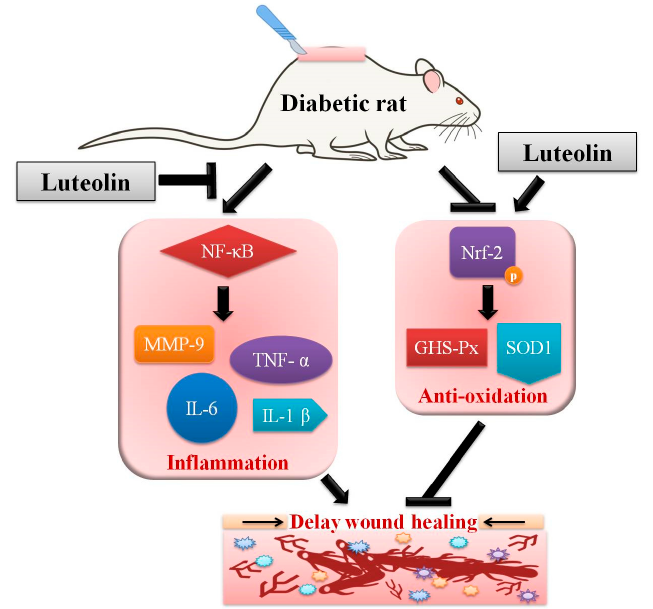
Figure 8. Schematic representation of action by luteolin on impaired wound healing in STZ-induced rats. Luteolin improves diabetic wound healing by inhibiting inflammation and improving antioxidative capacity, which associates with NF- κ B-mediates MMP-9, IL-6, TNF- α , and IL-1 β downregulation, and Nrf-2-mediates GHS-Px and SOD1 upregulation. Arrows: improve or increase. T-bar: inhibit.